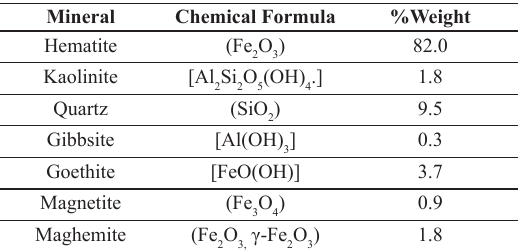
Table 1. Mineralogical composition of the iron ore sample (% by mass fraction).